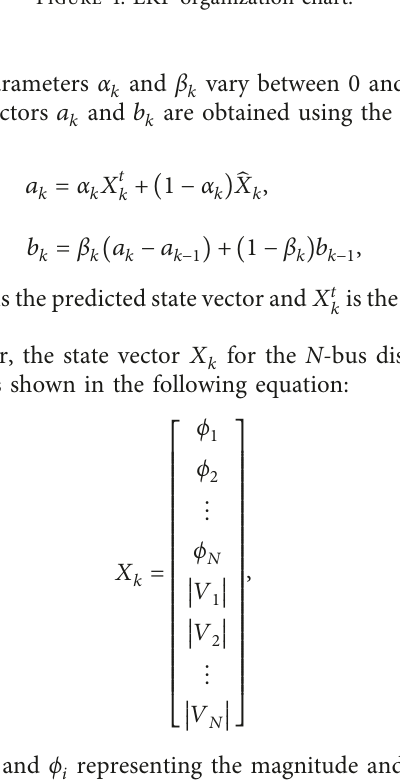
Figure 4: EKF organization